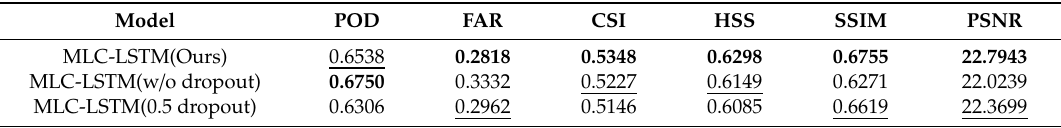
Table 3. Quantitative evaluation results of three models on six metrics. The mean value of six metrics of all 15 extrapolation steps is reported. The figures with bold-face indicate the best while the figures with underline indicate the second.